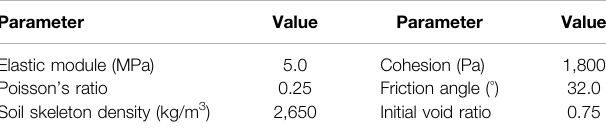
TABLE 1 | Table of parameters in SPH simulation of the model test.